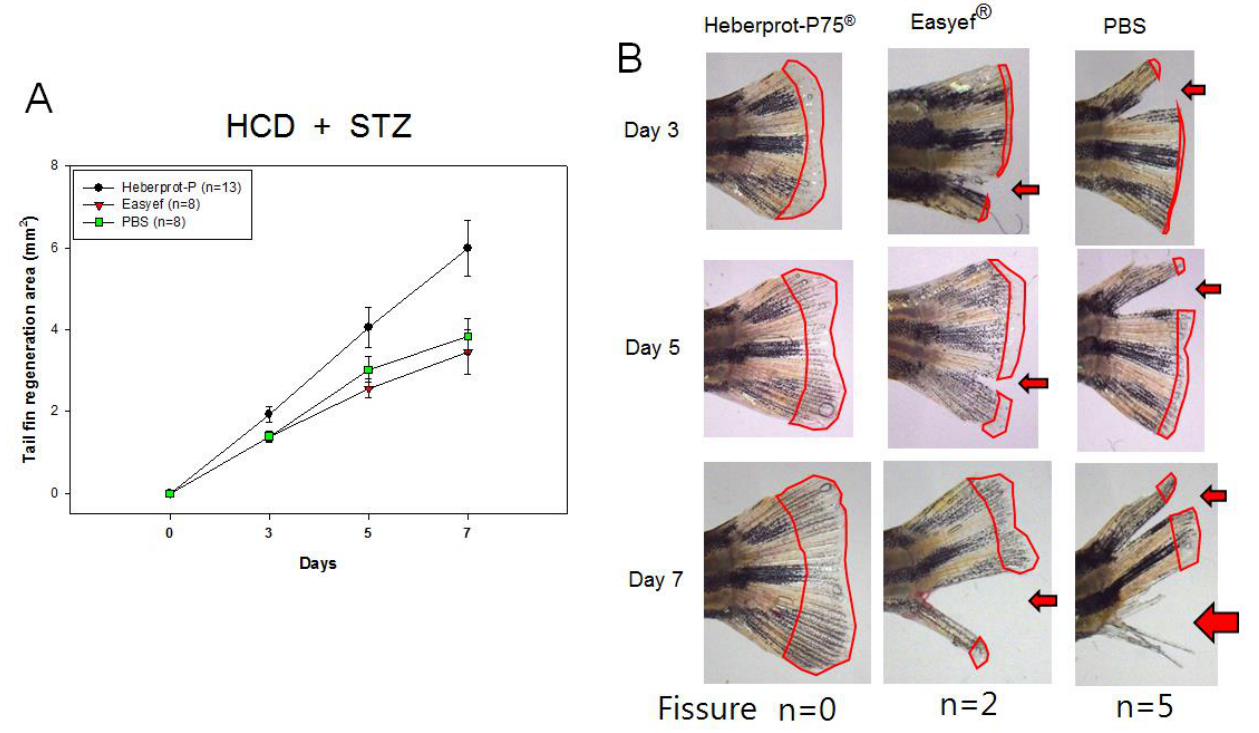
Figure 8. Comparison of the tissue regeneration speed ( A ) and morphology in tail fin area ( B ) under HCD consumption alone over seven days. The red arrow indicates the tail fissure. At bottom of photos, n indicates the number of zebrafish that showed fissure of tail fin on day 7. HCD, high cholesterol diet; STZ, streptozotocin.